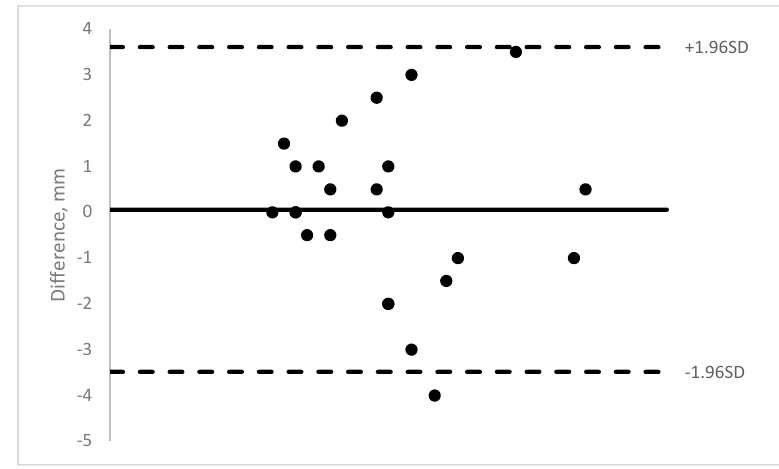
Figure 3. Bioptigen Bland–Altman plot of intra-operative measurements versus OCT